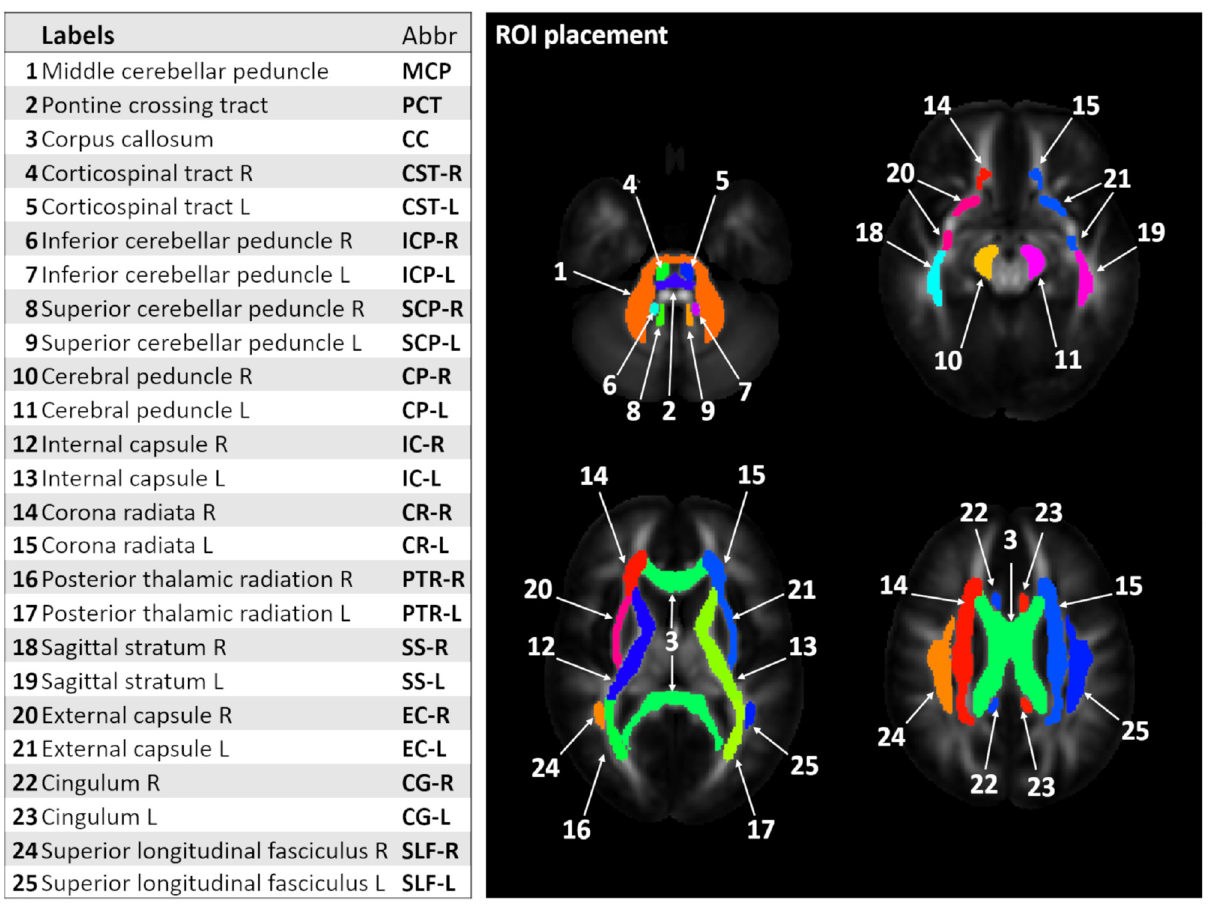
FIGURE 1 | Labels and corresponding abbreviations for region-of-interest (ROI) analysis. The figure shows 25 white matter (WM) ROI labels identified using the Johns Hopkins (JHU) WM template and atlas (